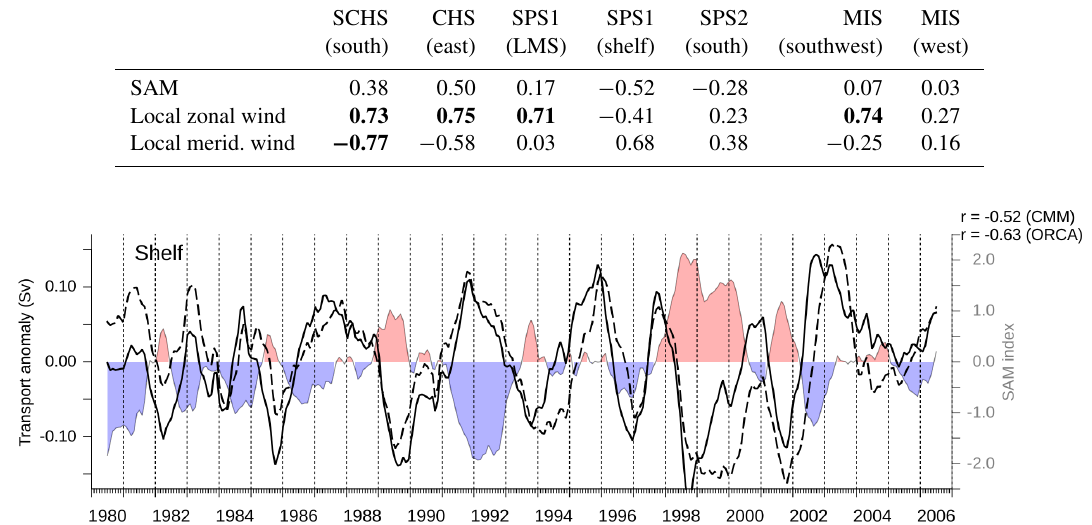
Figure 11. Monthly transport anomaly through the SPS1 shelf-break sections from CMM (solid line) and ORCA (dashed line), as well as the SAM index (positive and negative phases in red and blue, respectively). Correlations ( r ) between simulations and the SAM index are shown on the upper right-hand side. A 12-month running mean is applied to the data to filter the seasonal